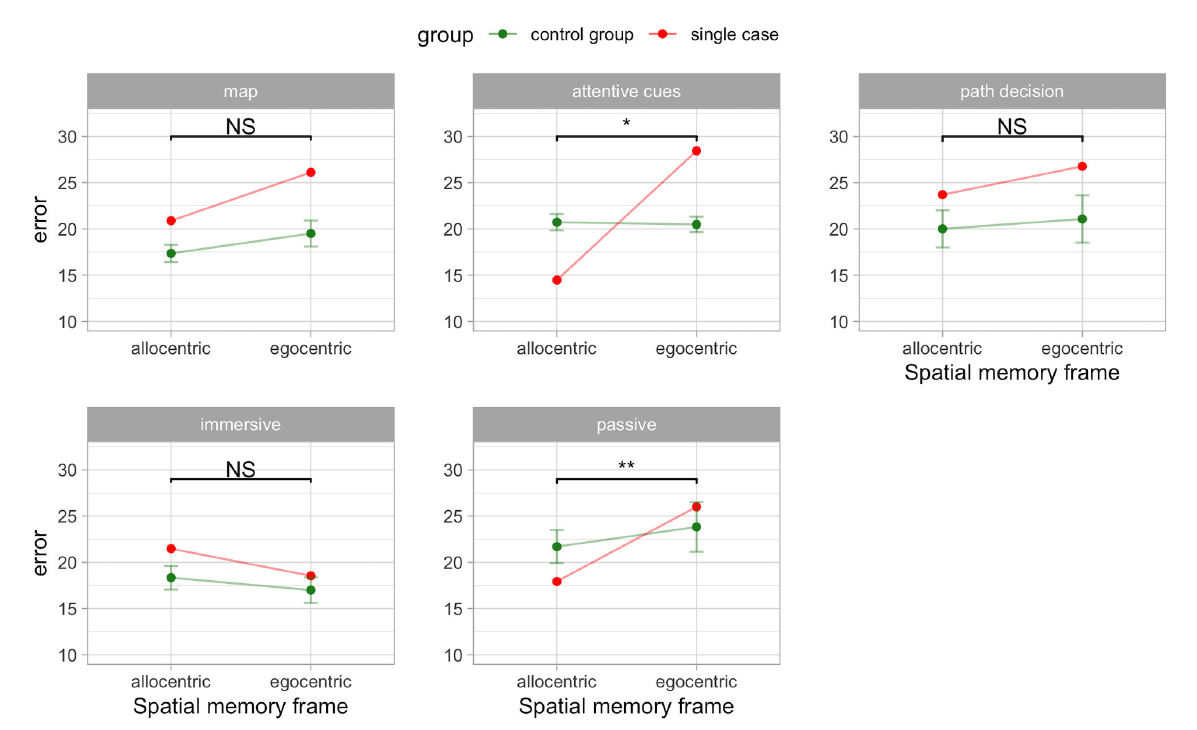
FIGURE2 Egocentric-allocentric dissociation in A.A. compared to the control group (PD without hallucinations) in the VR navigation conditions. Mean and 95% CI are shown for the control group. * p < 0.05; ** p < 0.01; NS: not